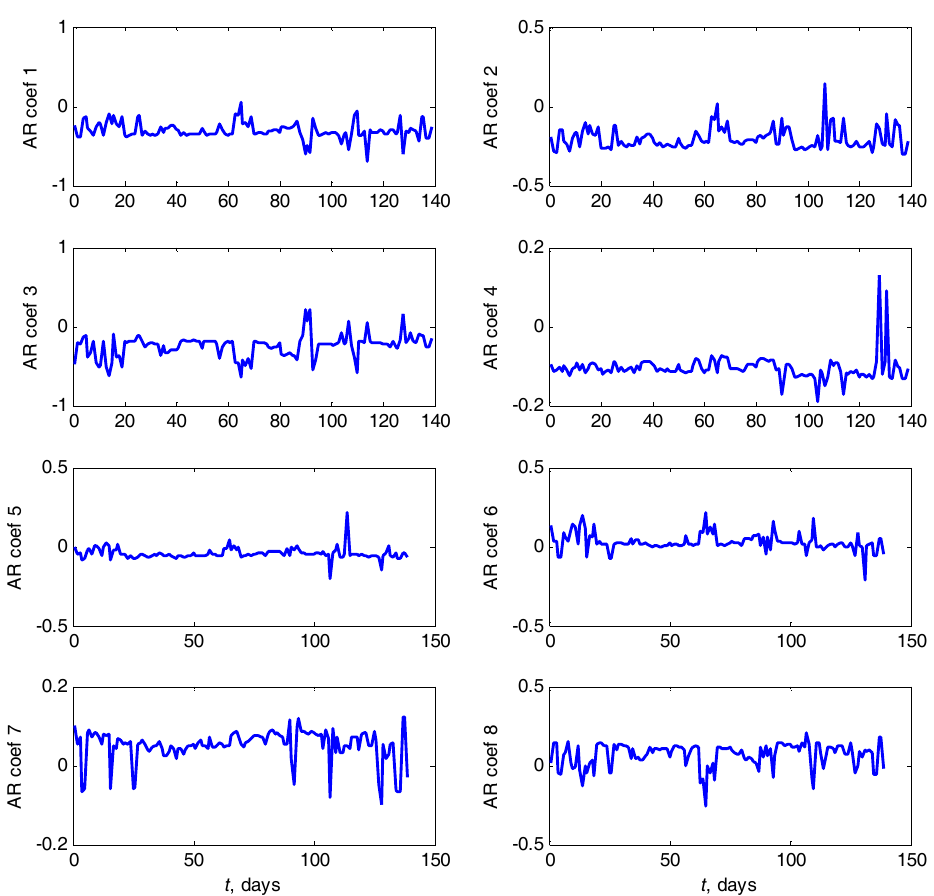
Figure 4. AR features (up to 8 coefficients) calculated from the vibration slew bearing signal.